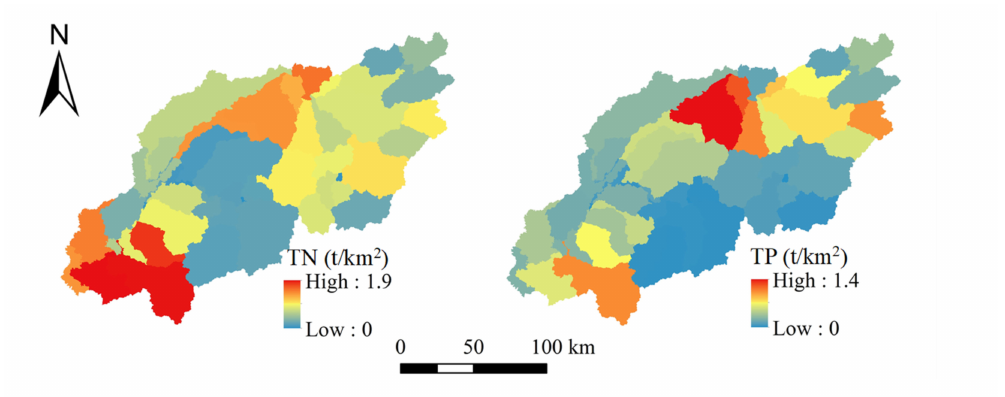
Figure 7. The spatial distribution of the average annual total nitrogen (TN) and total phosphorus (TP) yield from 2003 to